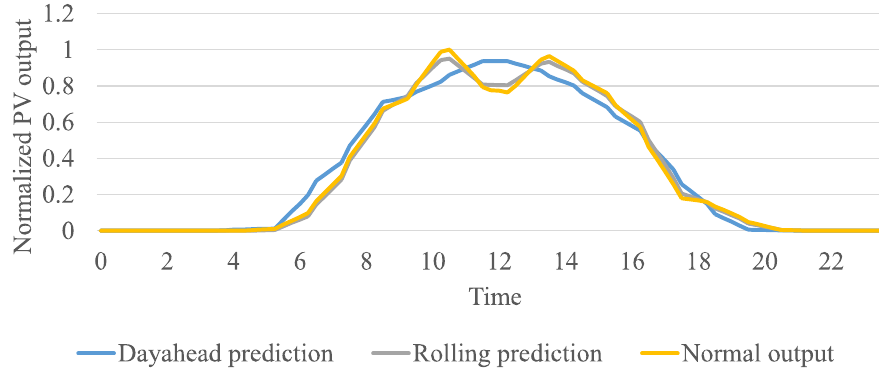
Figure 8. Photovoltaic output in normal operation. Table 5. Operation Results in Normal